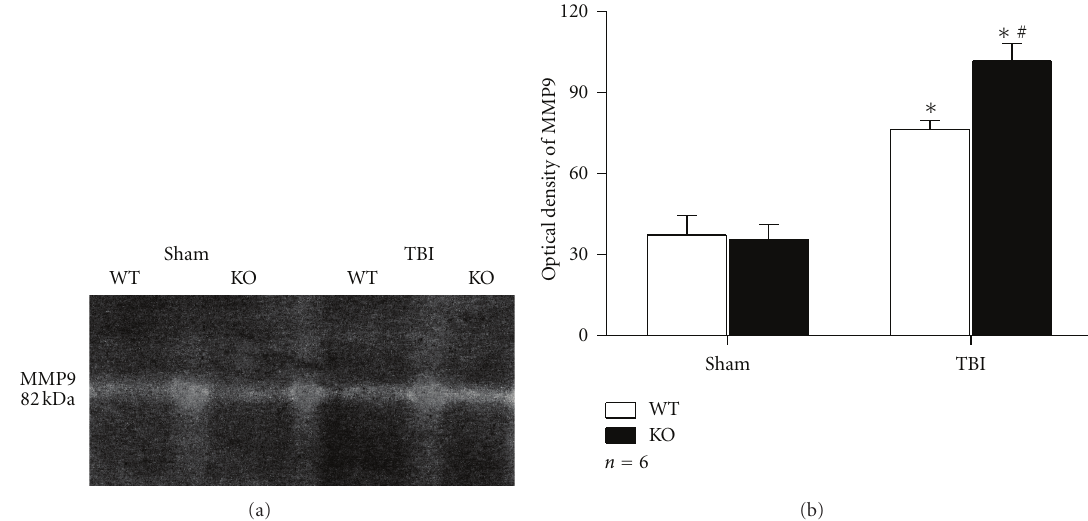
Figure 6: Gelatin zymography of MMP9 activity. (a) Gelatin zymography analysis showed higher MMP9 activity in group KO TBI than in group WT TBI. (b) Quantitative analysis showed that MMP9 activity was higher in astrocytes after scratch ( P < 0 . 01). Such elevation was much severe in group KO TBI than in group WT TBI ( P < 0 . 01). ( ∗ P < 0 . 01, compared with sham counterpart; # P < 0 . 01, compared with WT